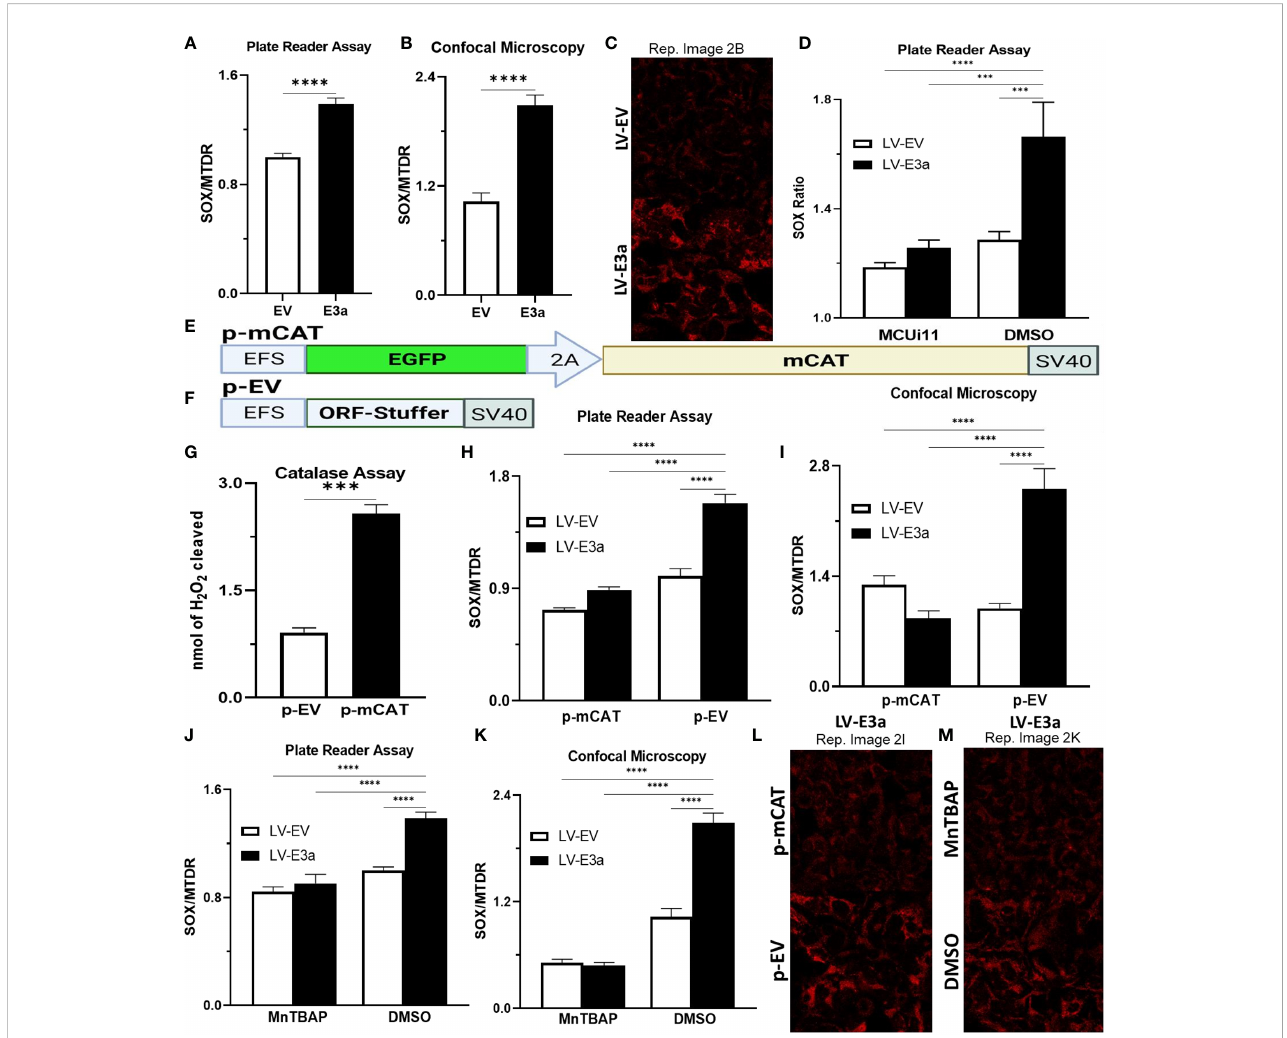
FIGURE 2 Expression of mCAT or treatment with the mROS scavenger MnTBAP antioxidant defenses blocks 2-E+2-3a induced mROS. (A – C) 24 hrs post- transduction cells were stained with MitoSOX and MTDR to measure mROS levels via (A) data from plate reader assays or (B, C) data from confocal microscopy. (D) 24 hrs post-transduction with LV-EV or LV-E3a 293T, cells were treated with or without 10 m M MCUi11, and then 2.5 m M TG and stained with MitoSOX to measure mROS levels by plate reader assays. (E, F) Schematics of p- p-mCAT and EV vectors. (G) Catalase assay through cleavage of H 2 O 2 in 293T cell lysates collected 24 hrs post-transfection with p-EV or p-mCAT. (H-M) 24 hrs post-transfection levels of mROS assessed using MitoSOX and MTDR fl uorescence 293T cells transduced with LV-EV or LV-E3a and transfected (H, I, L) with p-mCAT or its respective control p-EV or (J, K, M) cultured in the presence or absence of 50 m M MnTBAP, DMSO used as a negative control. MTDR fl uorescence was used to normalize for mitochondrial content with mROS expressed as the ratio of MitoSOX/MTDR, by (H, J) plate reader assays or (I, K, L, M) confocal microscopy. (C, L,